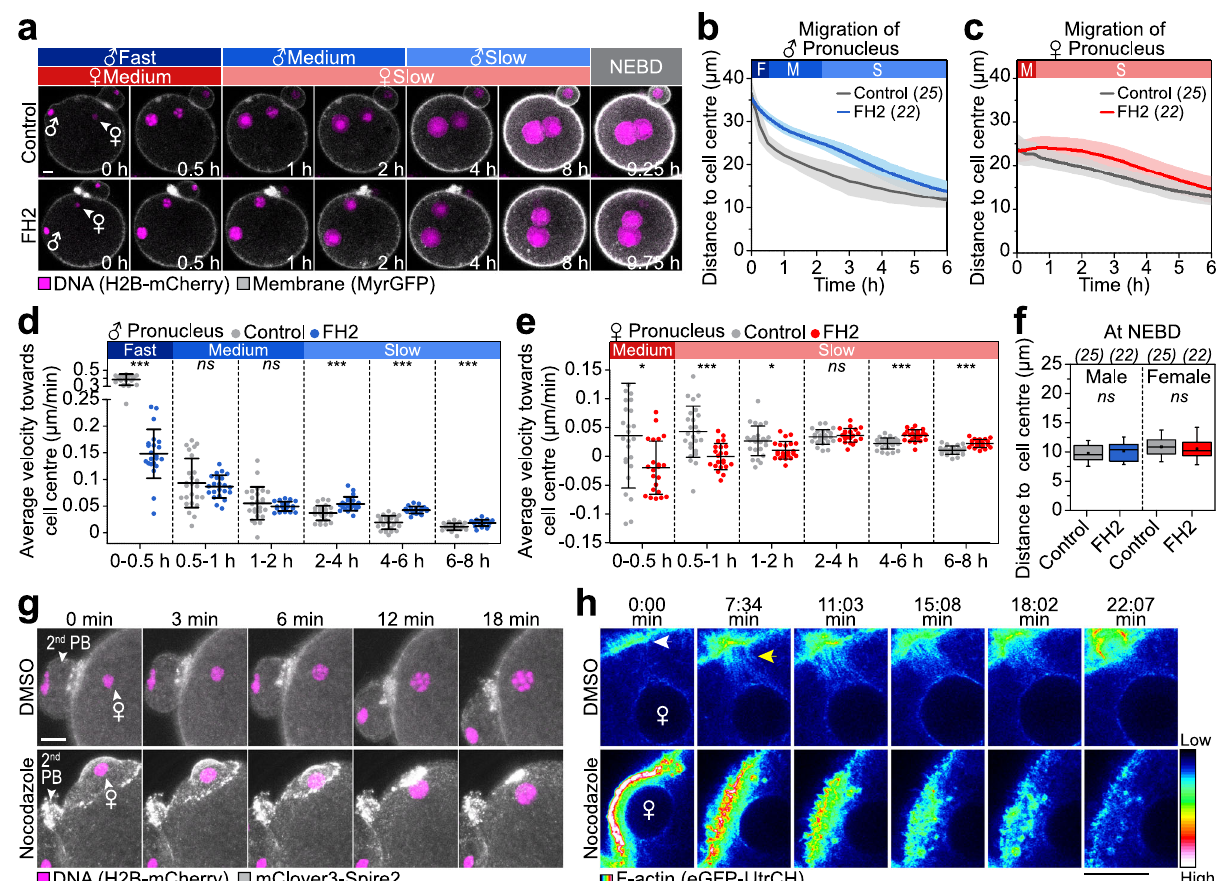
Fig. 6 The fast migration mode requires actin nucleation in the periphery of the zygote. a Three-dimensional time-lapse images of pronuclei and the cell surface relative to pronuclear formation (0 h) in zygotes injected with 3 μ M MBP (control) or FH2 until nuclear envelope breakdown (NEBD). Female ( ♀ ) and male ( ♂ ) genomes are shown. Phases with respective movement speeds are classi fi ed as in Fig. 1a. The mean distance (thick line) of male ( b ) and female ( c ) pronuclei centroids to zygote centre during pronuclear migration in zygotes injected with MBP or FH2 was calculated from ( a ). The total number of analyzed zygotes speci fi ed in italics was pooled from three independent experiments. S.d. shown as shaded areas. Statistical plots of average velocities of male ( d ) and female ( e ) pronuclei during pronuclear migration in zygotes injected with MBP or FH2 calculated from ( b ) and ( c ) with the same sample sizes as in ( b ) and ( c ), respectively. Statistical plots show mean ± s.d. Two-tailed Student ’ s t test was used to test for signi fi cance (from left to right: d p < 0.0001, p = 0.5, p = 0.4, p < 0.0001, p < 0.0001 and p = 0.0003; e p = 0.01, p < 0.0001, p = 0.01, p = 0.5, p < 0.0001 and p < 0.0001). f Distance of pronuclei centroids to zygote centre at NEBD for zygotes injected with MBP or FH2 calculated from data sets in ( a ). Box plot showing median (line), mean (small square), 5th, 95th (whiskers) and 25th and 75th percentile (box). Two-tailed Student ’ s t test was used to test for signi fi cance (male p = 0.4 and female p = 0.5). g Three-dimensional time-lapse images of with cortical mClover-Spire2 and female pronuclei in DMSO- or nocodazole-treated zygotes relative to pronuclear formation (0 min) in live zygotes (z-projection of 20 sections, every 1.5 µ m). Second polar bodies (PB) are labelled. h Super- resolution (airyscan) time-lapse images of mScarlet-Spire2 (white) and F-actin (EGFP-UtrCH, pseudocolour, 12-Bit grayscale) in live zygotes treated with DMSO or nocodazole in proximity of the forming female pronucleus displayed as single plane. Time point 0 marks the start of acquisition. Corresponding look-up table is shown as a colour scale bar ranging from intensity levels 1 (low) to 4096 (high). The brighter beans radiating from the cytokinetic furrow (white arrow) of the second polar body extrusion in DMSO-treated zygotes are actin fi laments located in the spindle remnant (yellow arrow) and appear distinct from the places that emerge below the cell surface in nocodazole-treated zygotes. Scale bars, 10 µ can trigger the same launching mechanism when it is forced to form directly underneath the cell surface and is also accelerated inwards by Spire and Formin-2 in unperturbed zygotes, albeit to a lesser degree than the male pronucleus.